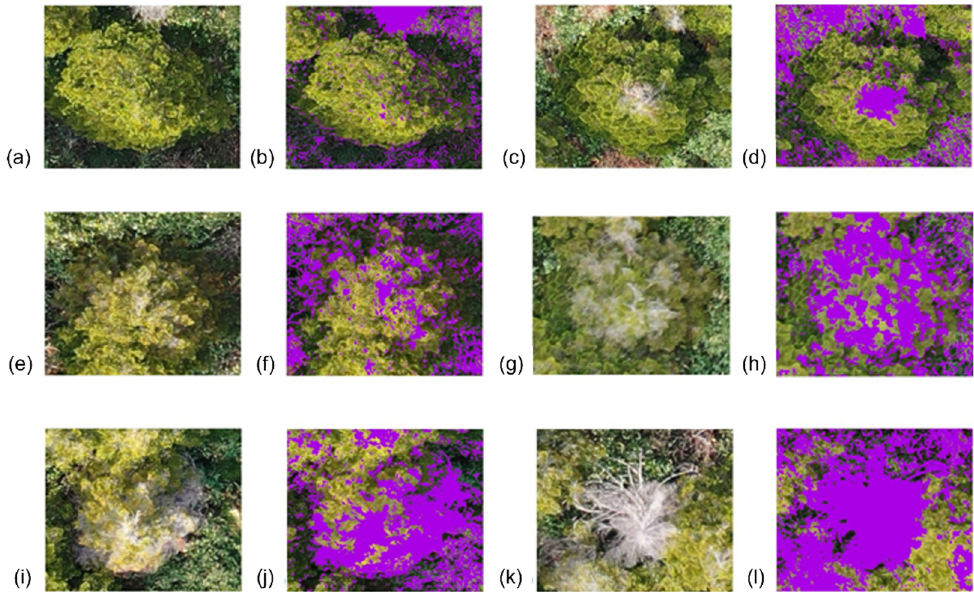
Figure 7. Results of white pixel detection and classification of fir tree health; Cat 1 ( a , b ), Cat 2 ( c , d ), Cat 3 ( e , f ), Cat 4 ( g , h ), Cat 5 ( i , j ), Cat 6 ( k , l ).